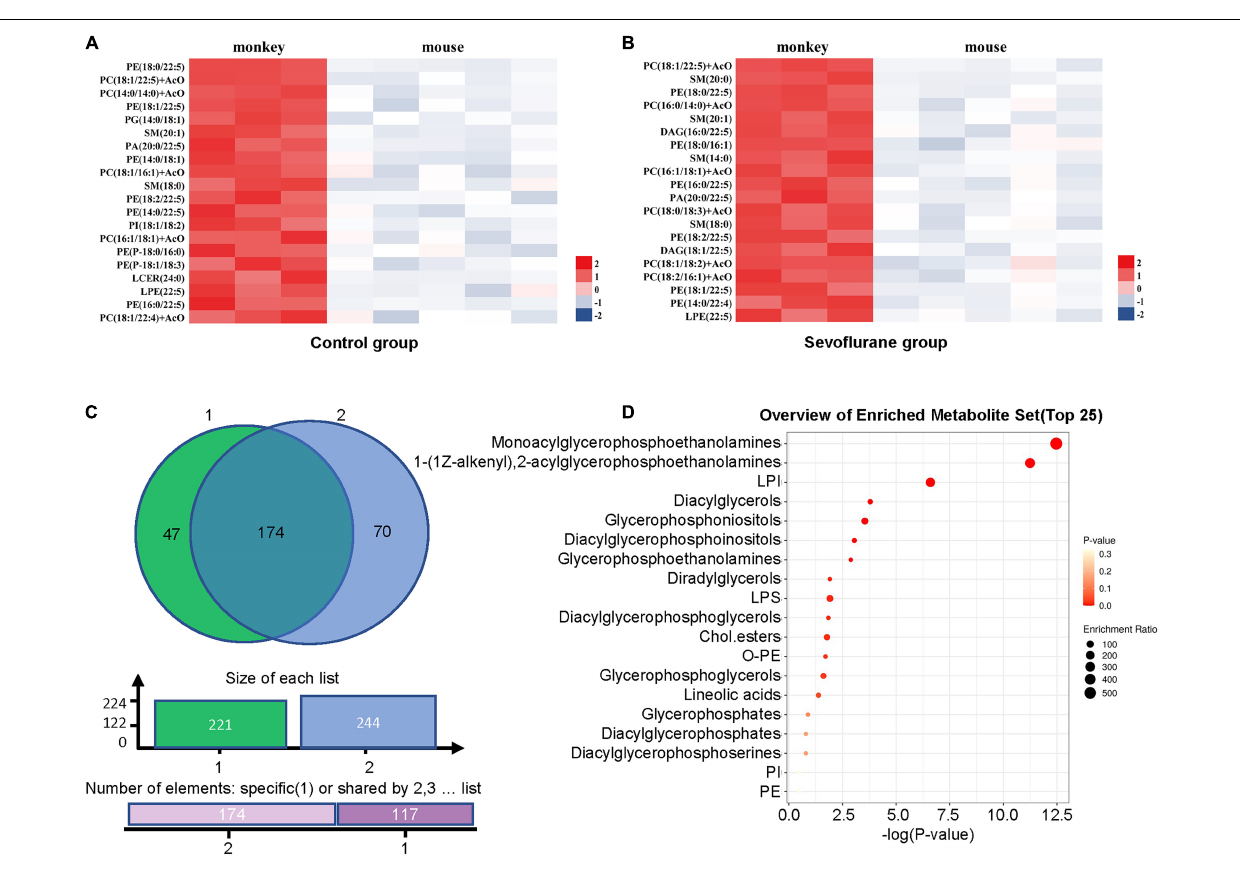
FIGURE 4 | Analysis of lipid differences between marmosets and mice in control group and sevoflurane group. (A) Heat map of differential lipids in the top 20 of control groups between marmosets and mice. (B) Heat map of differential lipids in the top 20 of sevoflurane groups between marmosets and mice. (C) Venn plot analysis. (D) Subclass enrichment